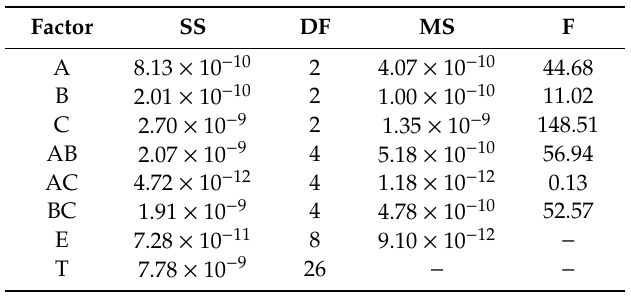
Table 5. ANOVA results derived after performing FEA by applying the orthogonal array in Table 3 and the modified factor levels in Table 4.